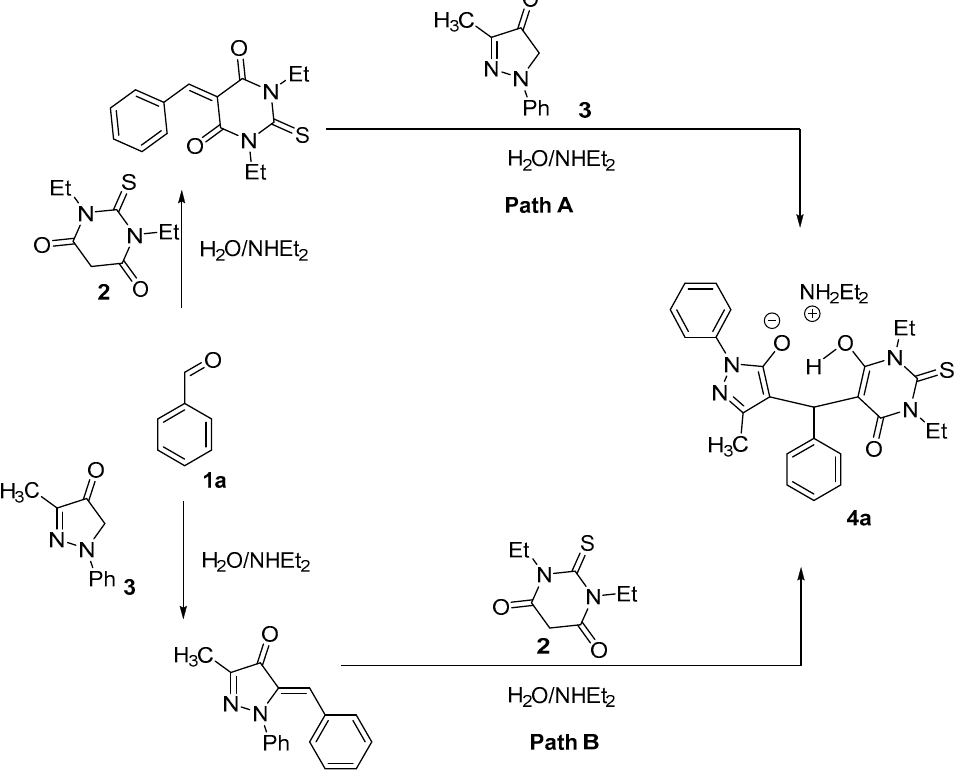
Scheme 2. Possible mechanism of the tandem Aldol-Michael reaction.